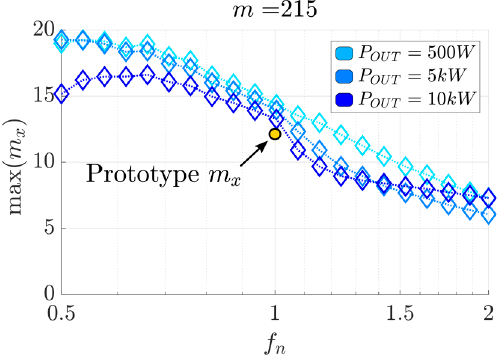
Figure 19. Auxiliary circuit maximum inductance ratio ( m x ) design criteria.